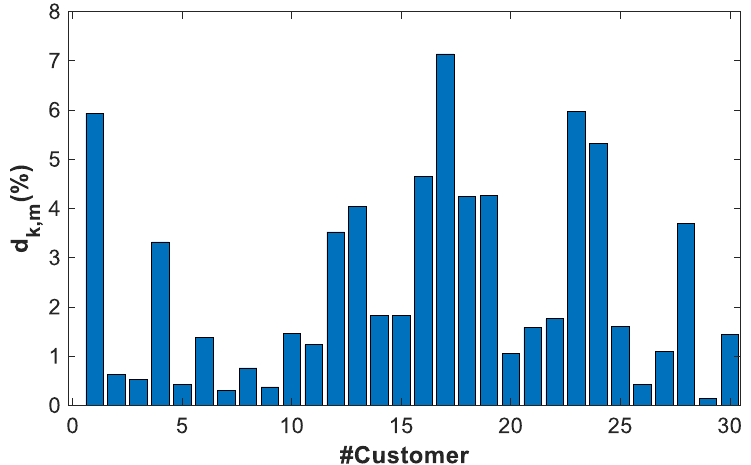
(cid:92) Figure 17. The partial deviation of the full energies profiles, 𝑌 𝐴𝐴𝐴𝐴−𝐵𝐴,𝑚 ̂ , of cluster k = AAAA-BA Y AAAA − BA , m , of cluster k = AAAA- Figure 17. The partial deviation of the full energies profiles, (cid:92) with the respect to the estimate power profile 𝑌 𝐴𝐴𝐴𝐴−𝐵𝐴 ̂ . The deviation is normalized by the con- Y AAAA − BA . The deviation is normalized by the BA with the respect to the estimate power profile tractual power of the cluster AAAA-BA (P AAAA-BA = 4 kW). contractual power of the cluster AAAA-BA (P AAAA-BA = 4